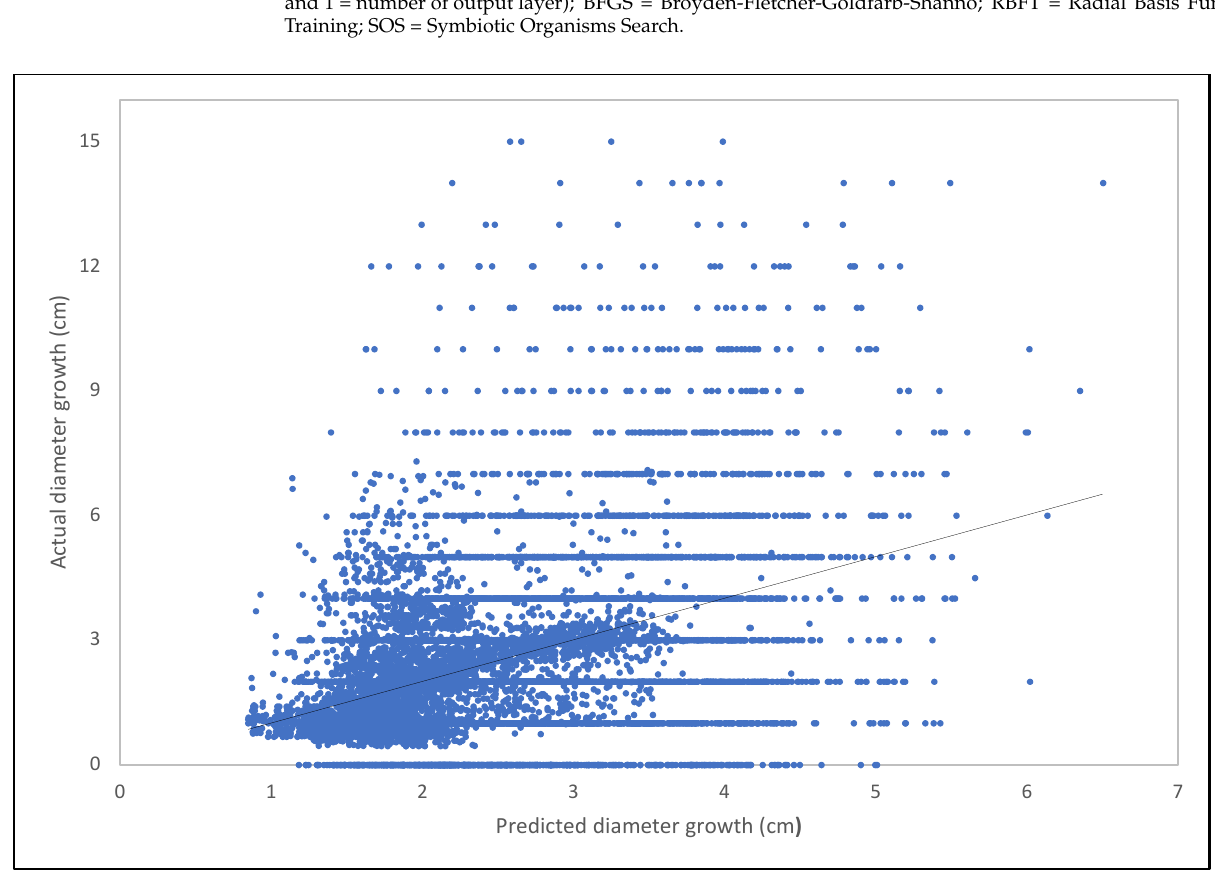
Figure 7. The relationship between predicted and actual diameter increment extracted by the mixed- effect model.